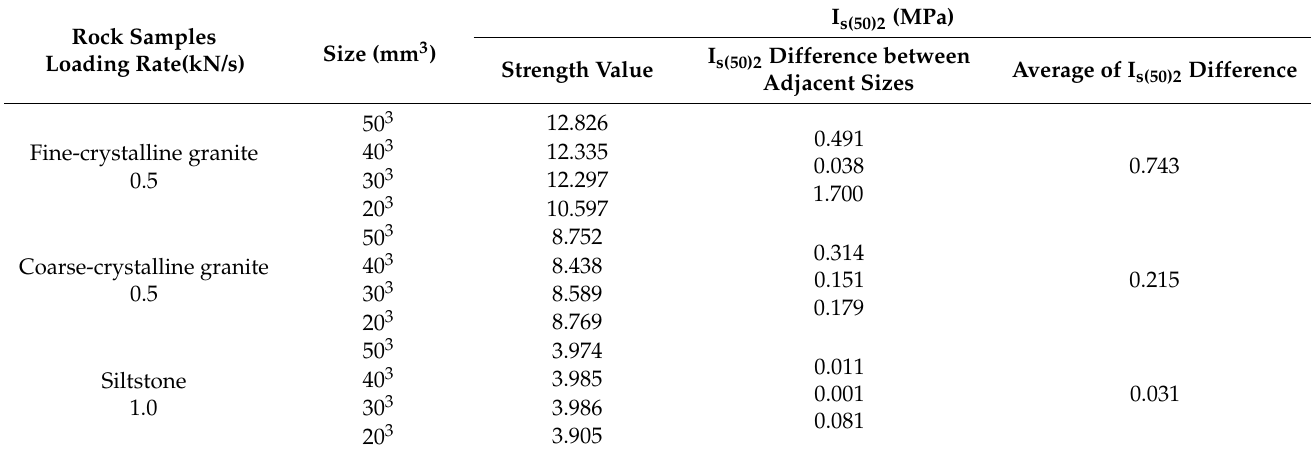
Table 8. Statistical table listing the I s(50)2 difference between different sizes for the three rock samples subjected to a reasonable loading